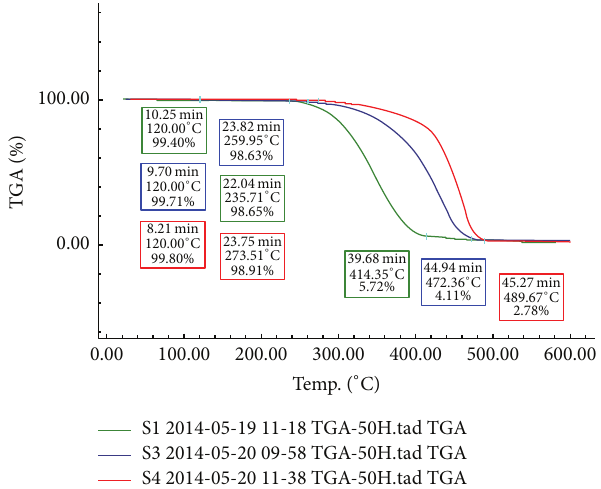
Figure 7: TGA analysis for different BBF/PP composites. Thermal analysis result, Center for Advanced Research in Sciences, University of Dhaka.